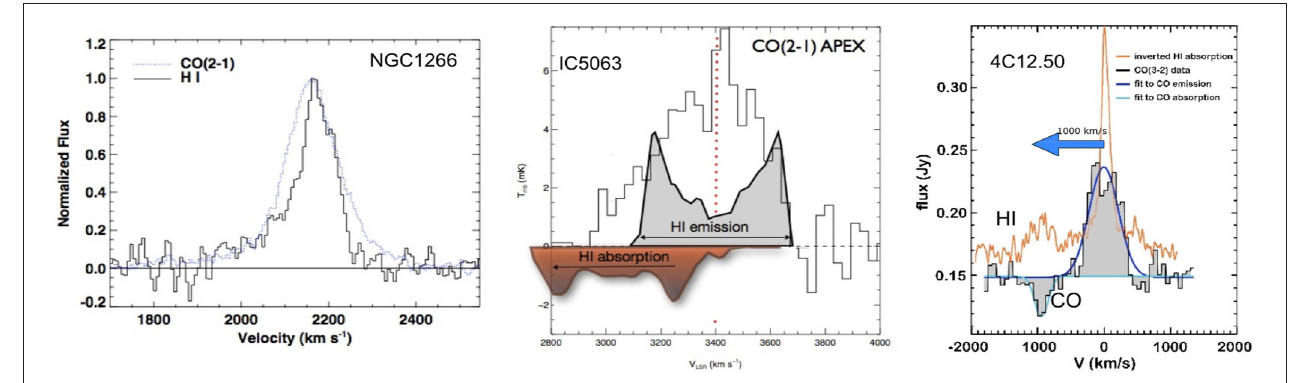
FIGURE 3 | Three examples of HI and CO integrated line profiles suggesting similar kinematical properties of the two phases of the gas, From left to right: NGC1266 (figure taken from Alatalo et al., 2011, © AAS. Reproduced with permission), IC5063 (figure taken from Morganti et al., 2013b, reproduced with permission © ESO) and 4C12.50 (Figure taken from Dasyra and Combes, 2012, reproduced with permission ©